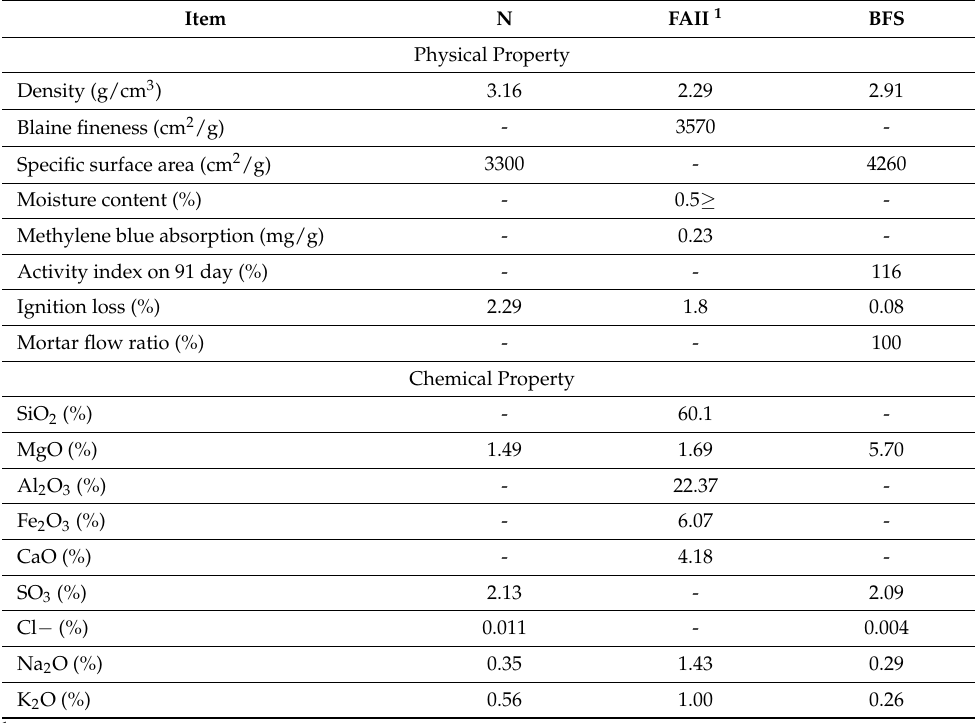
Table 2. Main quality of cement and mineral admixtures.